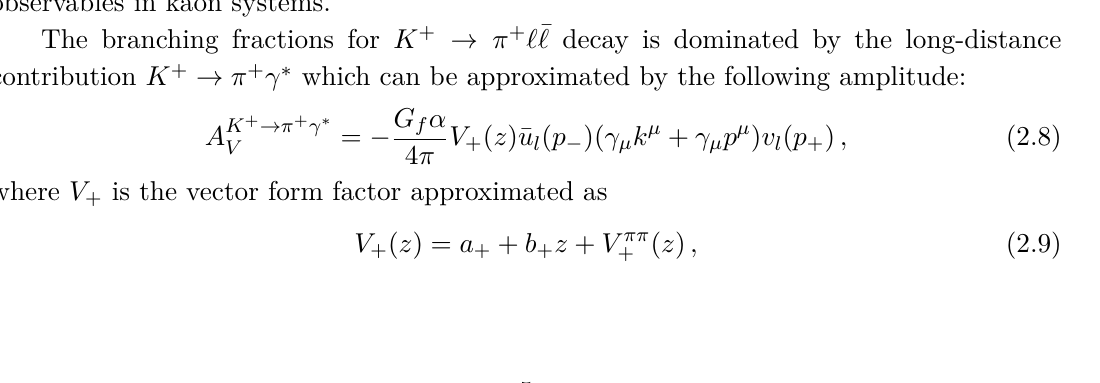
Figure 1 . BR( K + → π + ¯ νν ) (left) and BR( K L → π 0 ¯ νν ) (right) as a function of δC e δC τ . The dotted grey line represents the lepton flavour universality scenario. In the left plot, the L brown solid (dotted) line corresponds to the measured central value ( 1 σ experimental uncertainty) by NA62 [15]. In the right plot, the upper bound on BR( K L → π 0 ¯ νν ) is not visible for the scanned